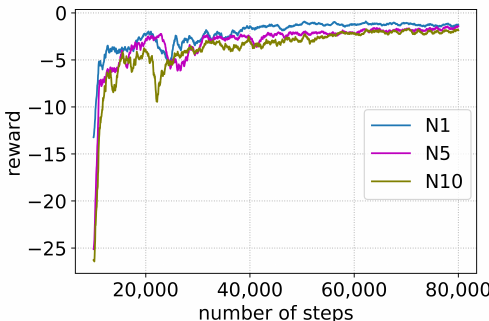
Figure 7. Moving average rewards over 1000 successive learning steps over the number of steps during static learning application of the proposed DRL VVC algorithm.